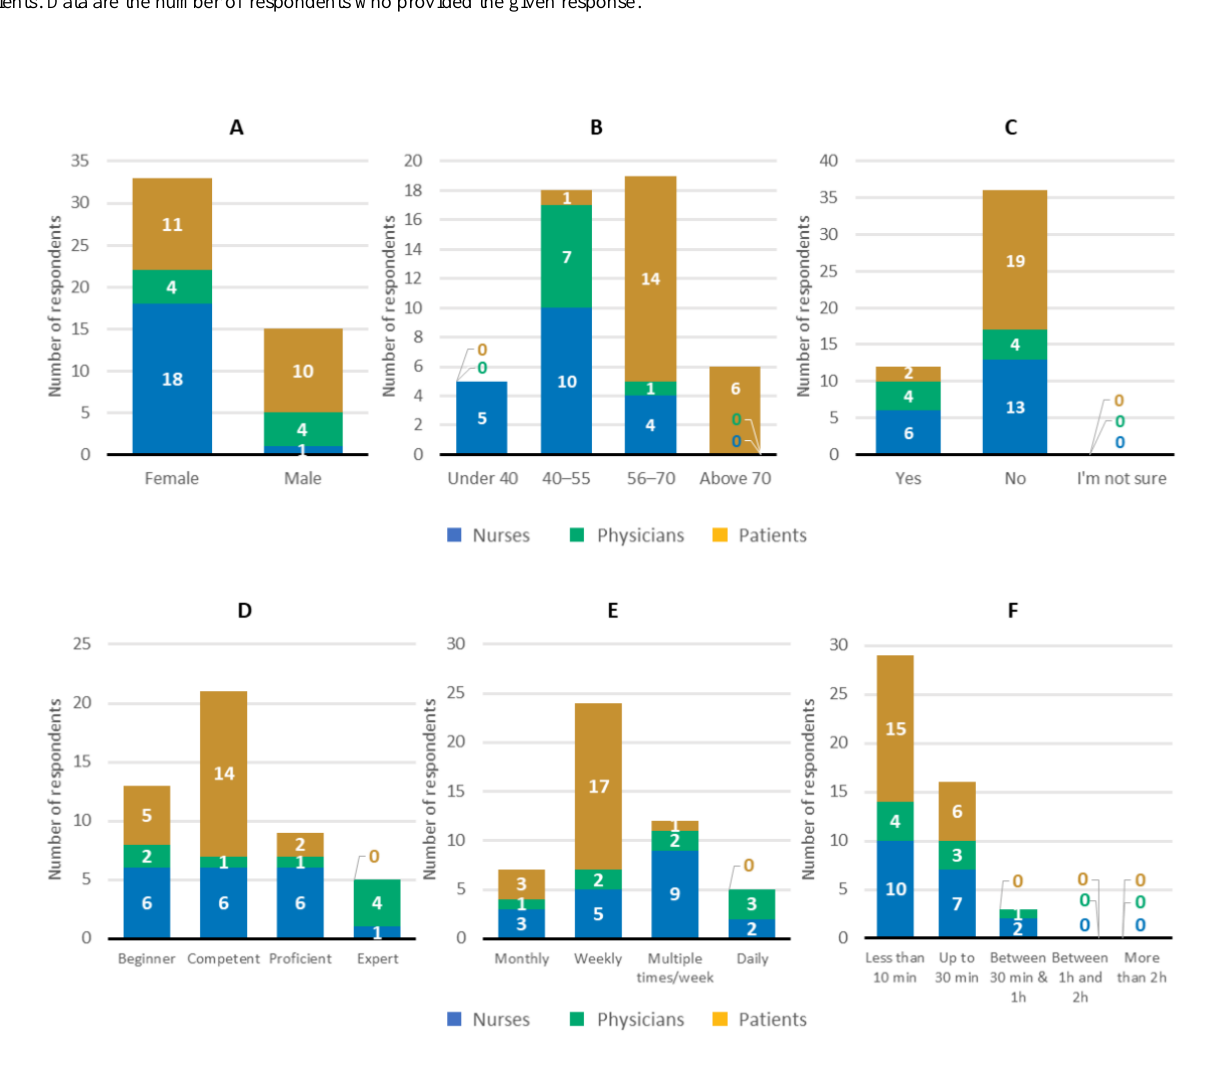
Figure 1. Characteristics of end-of-study survey respondents and digital patient monitoring and management (DPMM) tool usage (N=48: 19 [40%] nurses, 8 [17%] physicians, and 21 [44%] patients). (A) gender, (B) age, (C) DPMM use (ie, response to "Have you used Kaiku Health or other similar digital monitoring tools before this pilot?"), (D) level of proficiency (ie, response to "How would you rate your current proficiency level with regard to Kaiku Health?"), (E) usage rate (ie, response to "How often do you use Kaiku Health?"), and (F) time spent per session using the tool for clinicians and patients. Data are the number of respondents who provided the given response.